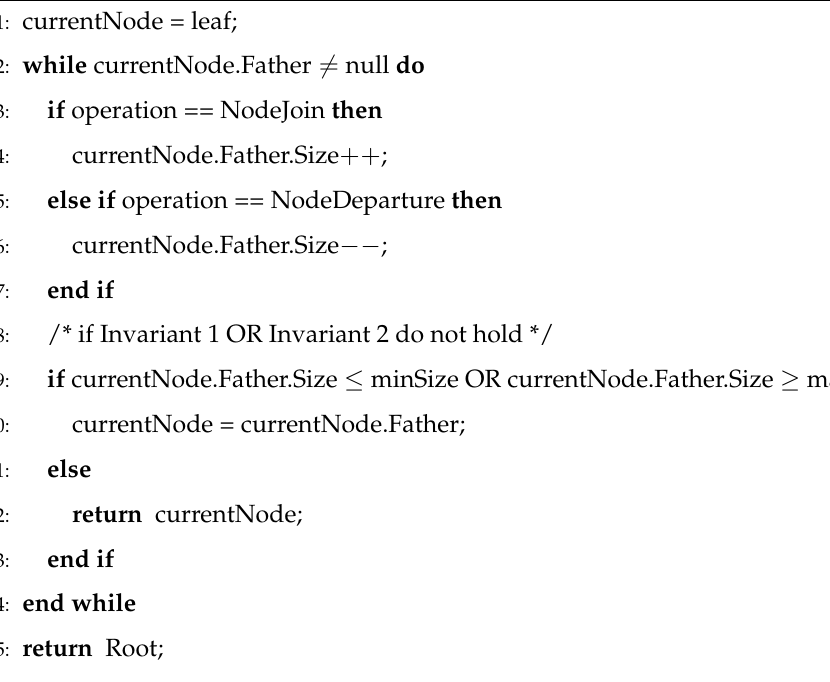
Algorithm 2 UpdateVirtualSize (BinaryNode leaf, NodeUpdate operation)